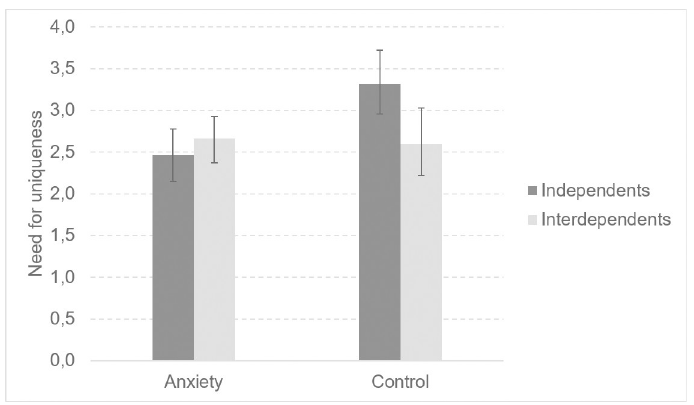
Fig 1. The effects of anxiety and self-construal on the preference for groups-linked products. Error bars represent standard errors estimated using the bootstrap method (95%).